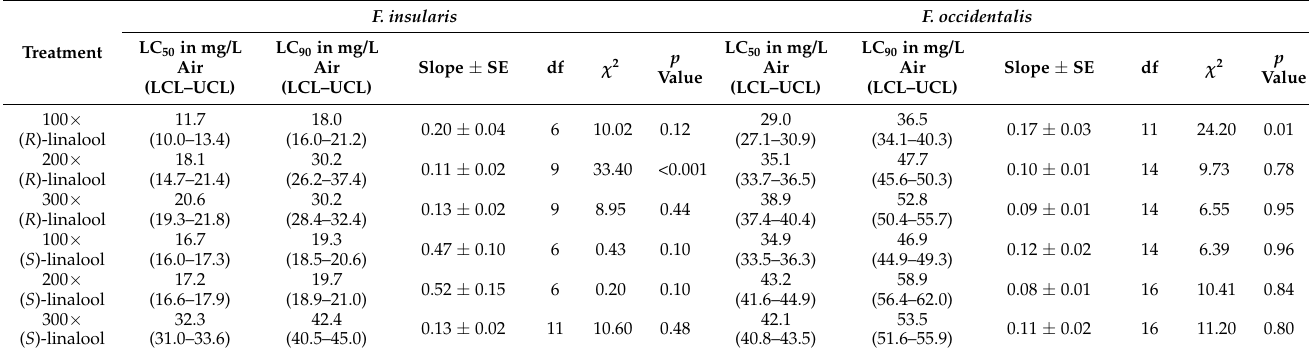
Table 1. LC 50 and LC 90 values for different treatments of F. insularis and F. occidentalis ( n = 4).